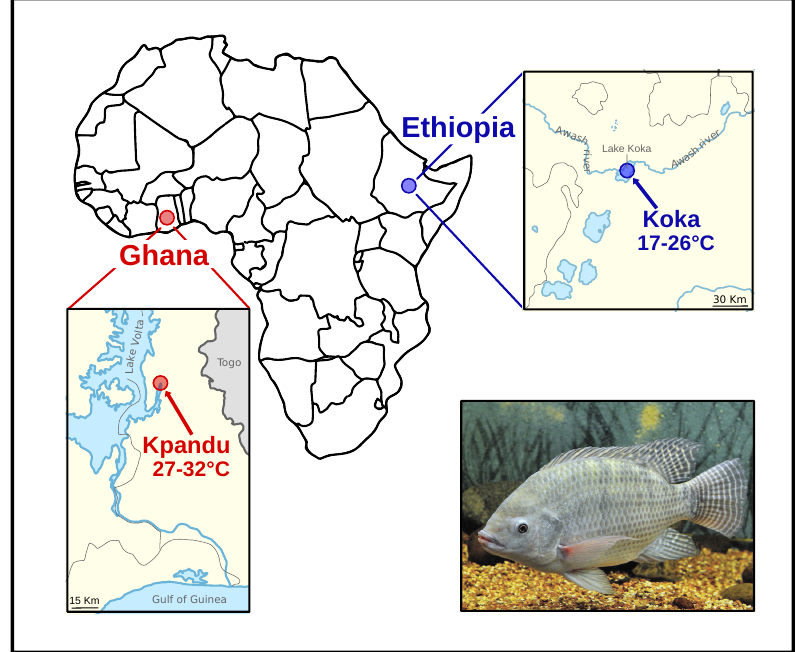
Figure 1. Map of Africa showing Ghana in West Africa with the location of the Kpandu population in Lake Volta (with medium to hot temperatures) and Lake Koka (a cold lake) located in the Ethiopian highlands of the East African